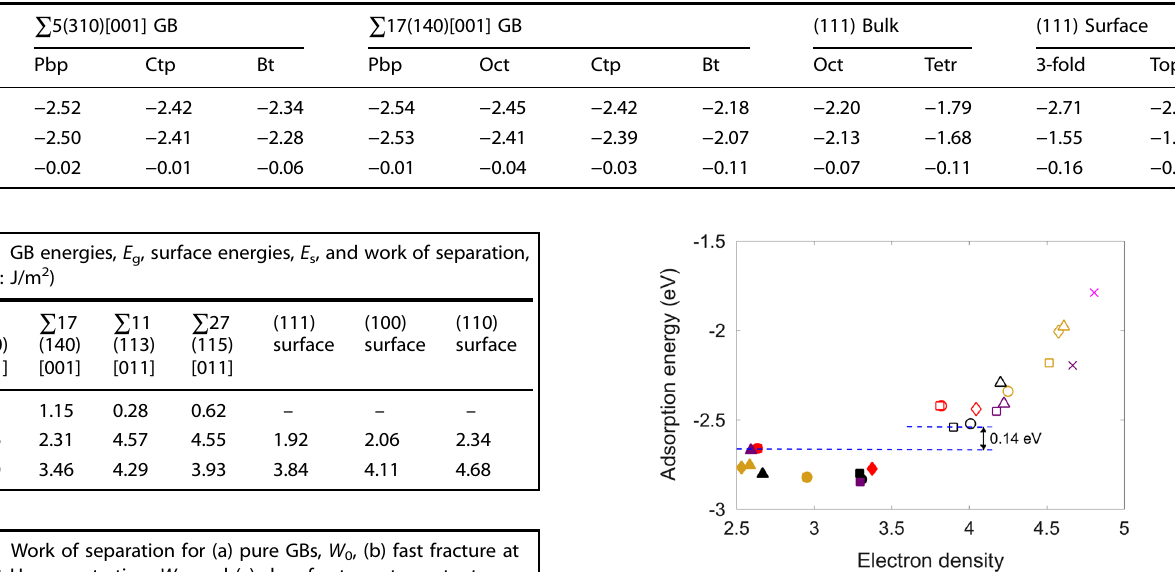
and mechanical contribution E ad chem